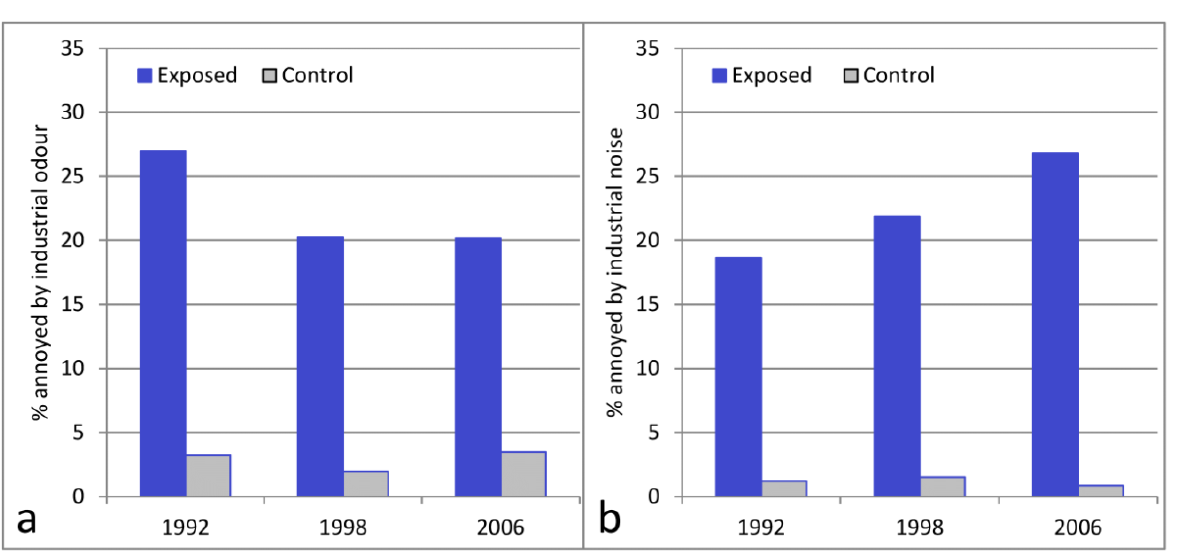
Figure 3. Prevalence of annoyance. The results from the exposed areas (North, Central, and South Stenungsund, and Odsmal) are weighted together and compared to the control area (Kungalv). Annoyance from industrial odour ( a ); annoyance from industrial noise ( b ).